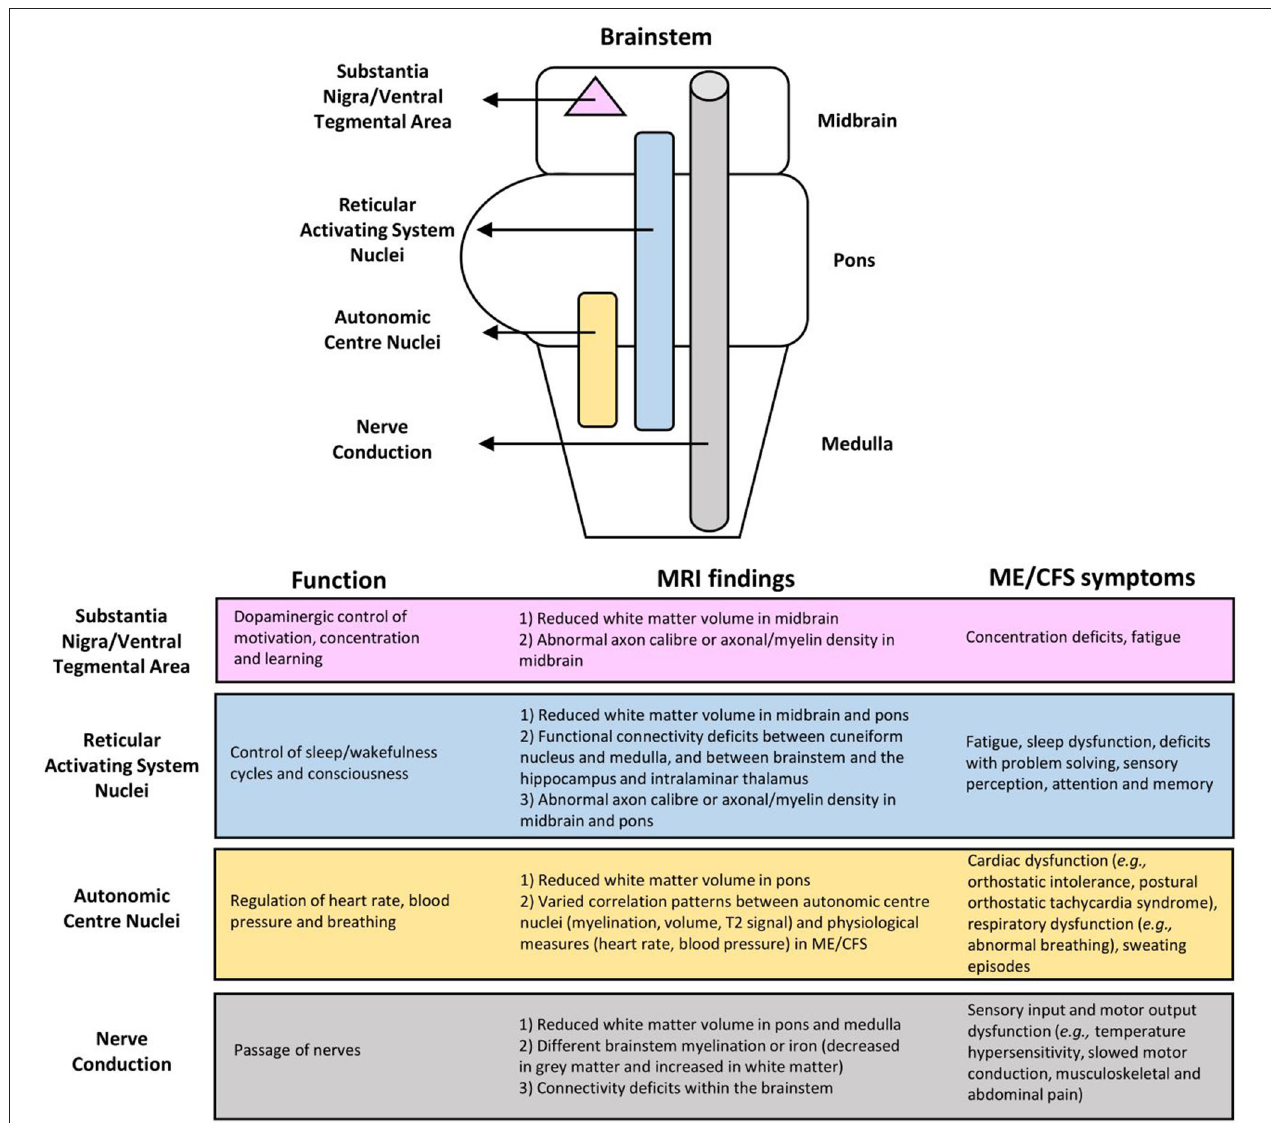
FIGURE 3 | Associations of myalgic encephalomyelitis/chronic fatigue syndrome (ME/CFS) symptoms with brainstem dysfunction based on MRI